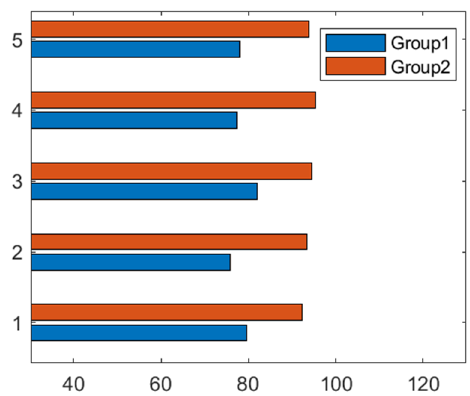
Figure 12. Distribution of planting qualified rate.